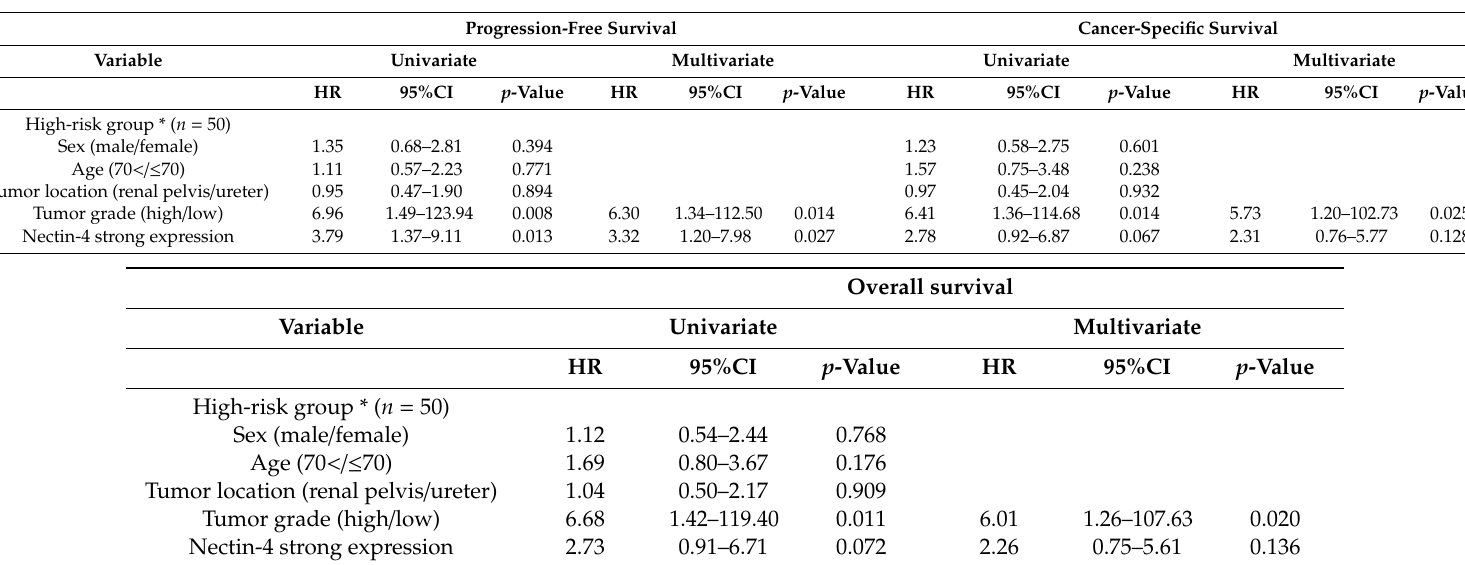
Table 4. Univariate and multivariate analyses of progression-free survival, cancer-specific survival, and overall survival in patients with high-risk UTUC. Progression-Free Survival Cancer-Specific Survival Variable Univariate Multivariate Univariate Multivariate HR 95%CI p -Value HR 95%CI p -Value HR 95%CI p -Value HR 95%CI p -Value